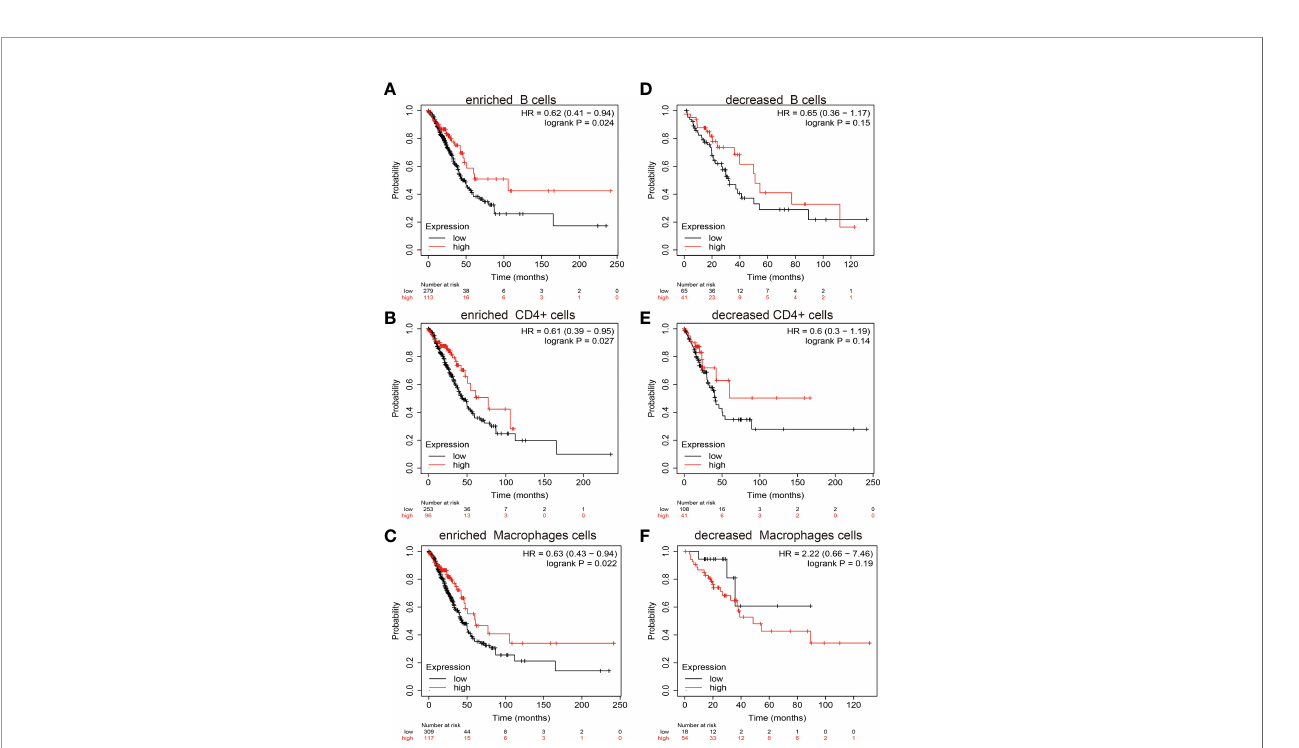
FIGURE 11 | Analysis the correlation between miRNA-30a-5p expression and diverse immune in fi ltration. (A – C) Correlation between miRNA-30a-5p and various immune in fi ltrate in LUAD.